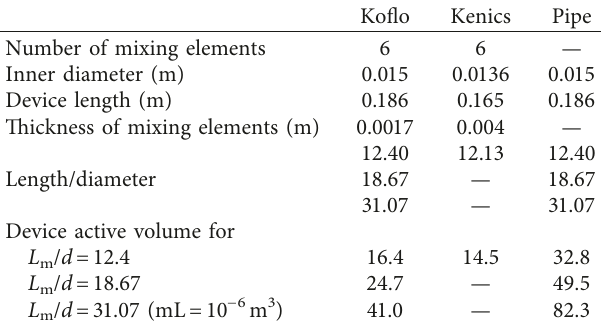
Table 1: Dimensions of the tested devices.